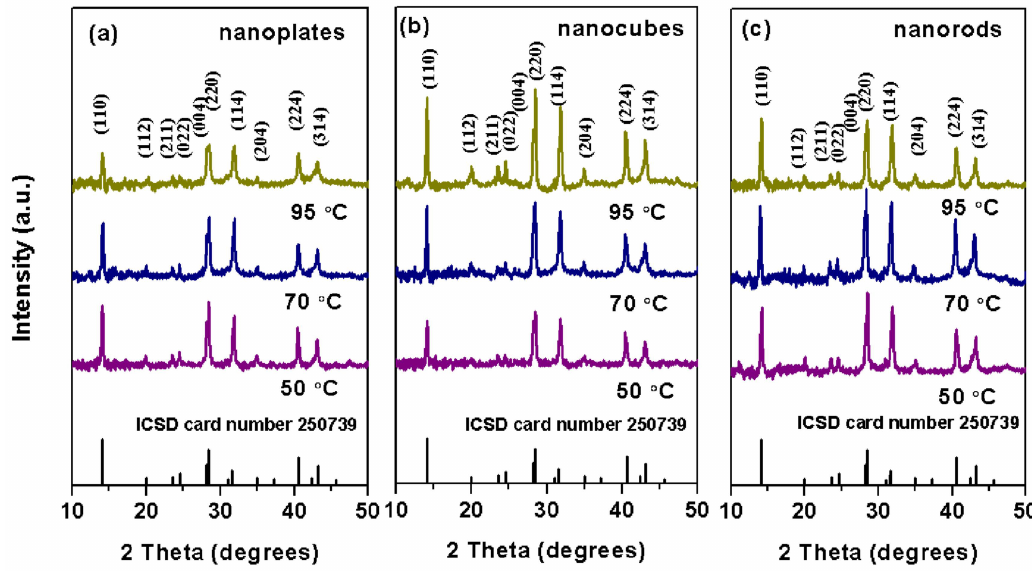
Figure 4. X-ray di ff raction patterns of MAPbI 3 ( a ) nanoplates, ( b ) nanocubes, and ( c ) nanorods dried at 50 ◦ C, 70 ◦ C, and 95 ◦ C.